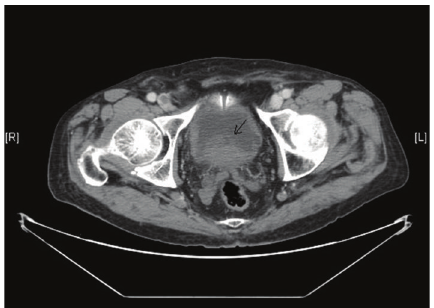
Figure 1: Computed tomography revealing a 5cm size heterogeneous mass in the right wall and base of the bladder.